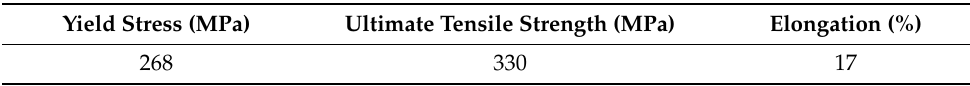
Table 2. Mechanical properties of AA6061-T6 alloy.